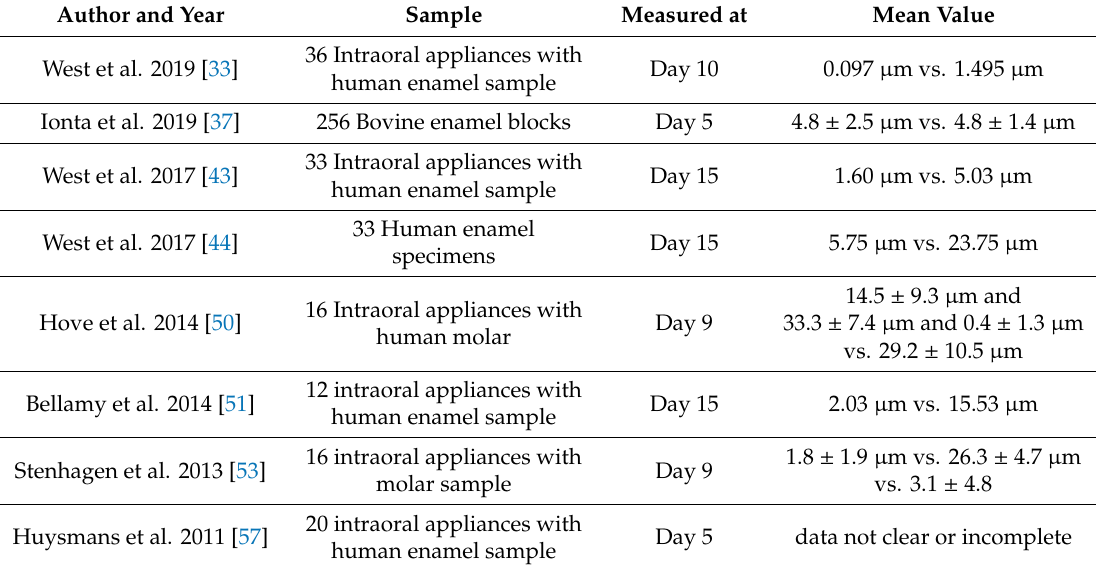
Table 4. Obtained data and meta-analysis on enamel wear